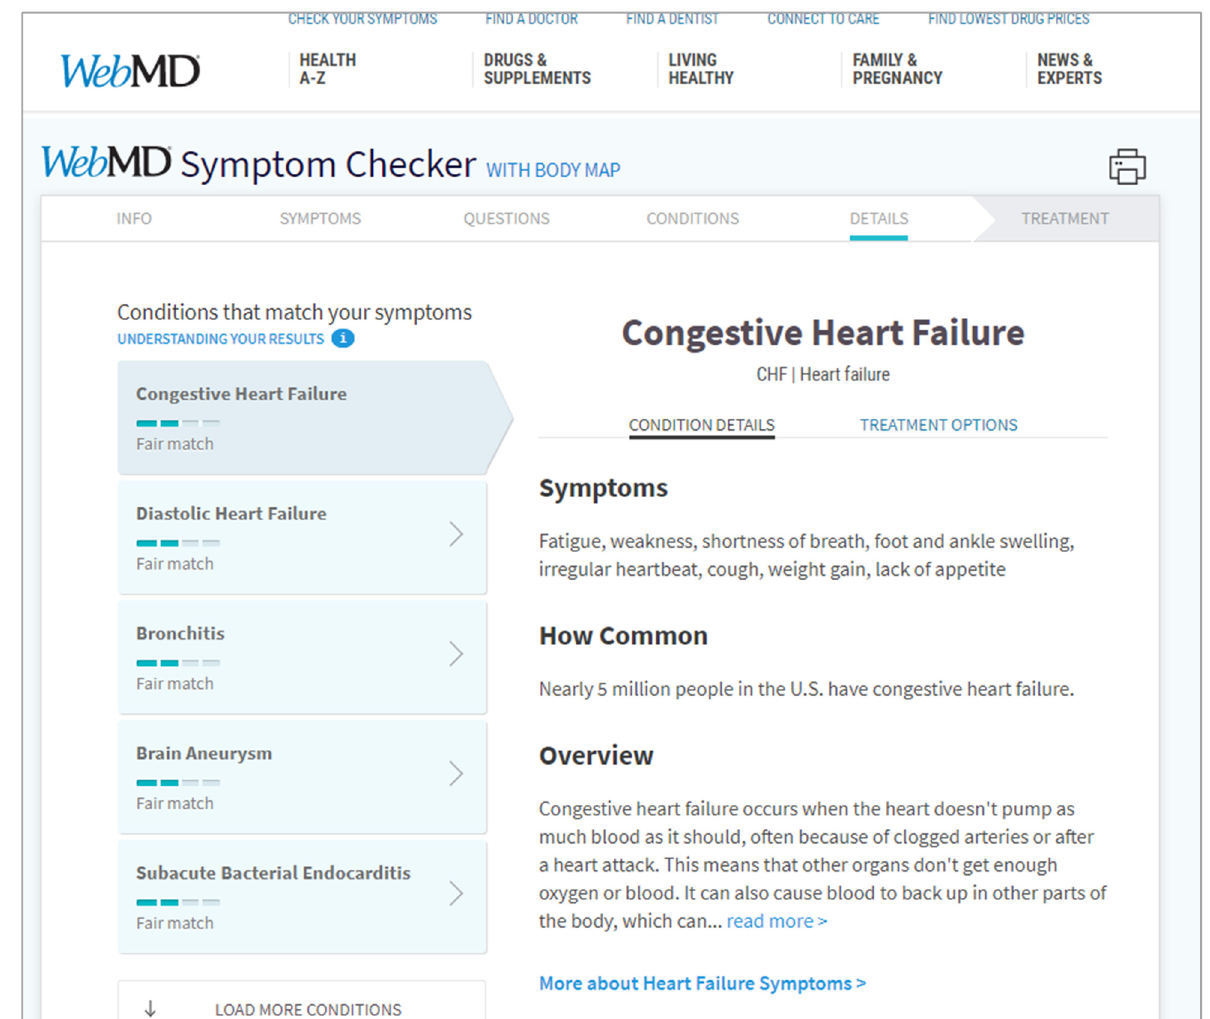
Figure 3. WebMD’s Symptom Checker: an example of a structured–like query expansion interface strategy for a search task. In this use case, users are guided along a series of query building opportunities, allowing them to enter various symptoms and personal health criteria while aligning their personal vocabulary with the information resource vocabulary. Source: Image generated on 18 January 2021, using the public web portal provided by WebMD, https://symptoms.webmd.com/ (accessed on 18 January 2021).